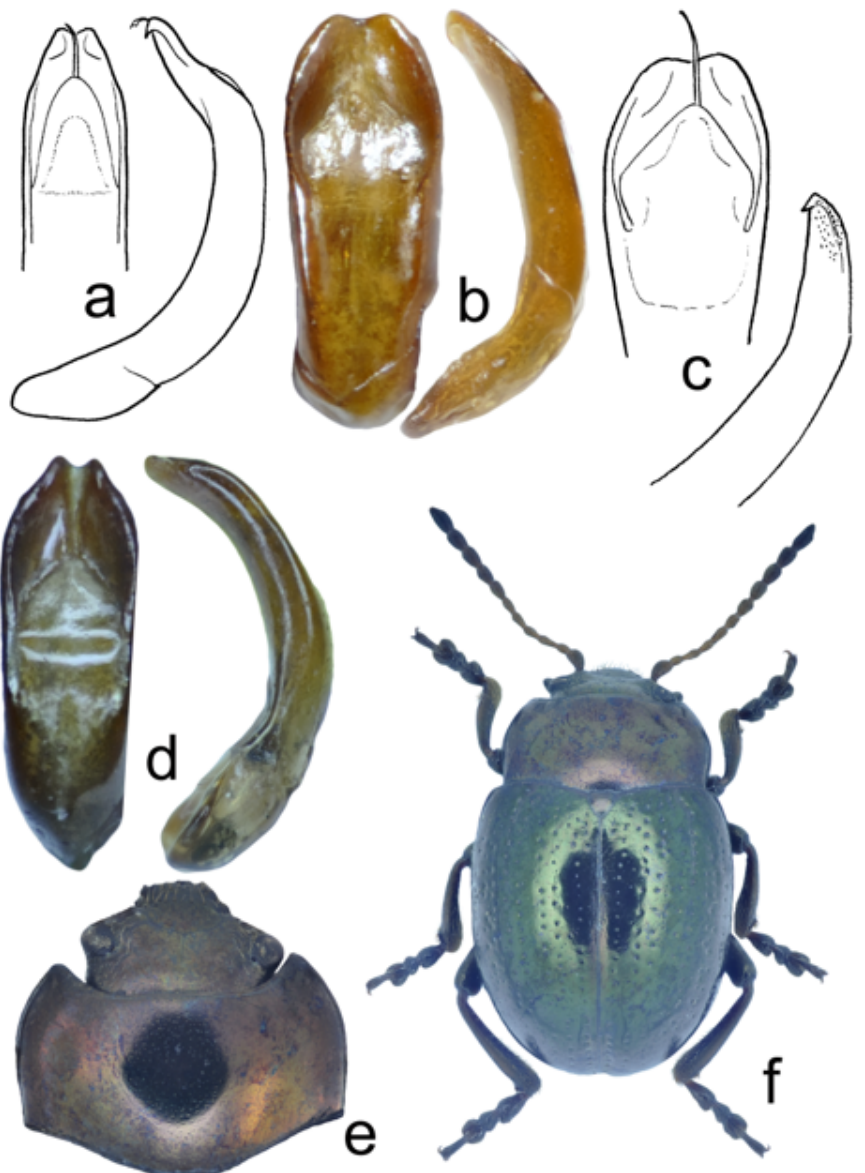
Figure 11. Chrysolina , structural details: ( a ) Ch. genriki sp. nov., holotype, aedeagus dorsal and lateral view; ( b , c ) Ch. igori sp. nov., holotype, aedeagus, dorsal and lateral view; ( d – f ) Ch. ilyakabaki sp. nov., holotype: ( d ) aedeagus, dorsal and lateral view; ( e ) head and pronotum, dorsal view; ( f ) total dorsal view.